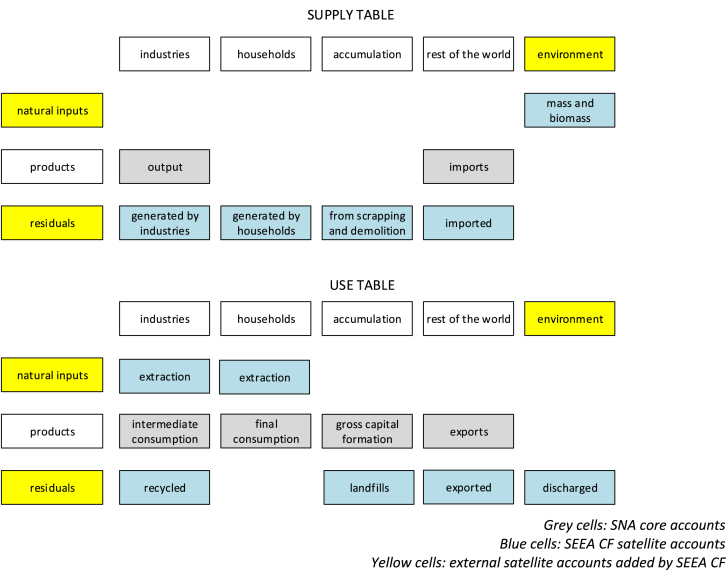
Graphical simplification of monetary Supply and Use table in the SEEA CF (source: adapted from La Notte et al., 2017b).